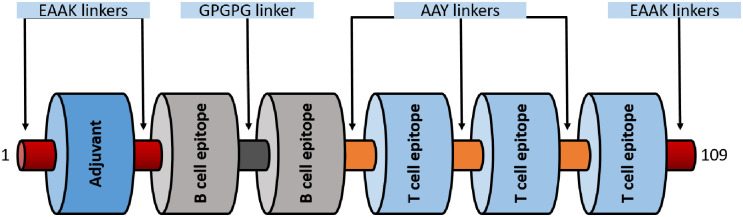
A diagrammatic representation of the final multi-epitope vaccine peptide.The 109-amino acid long peptide sequence containing an adjuvant (blue) at the N-terminal end linked with the multi-epitope sequence through an EAAAK linker (garnet). T cell epitopes are linked with the help of AAY linkers (orange) while the B cell epitopes are linked using GPGPG linkers (dark grey).